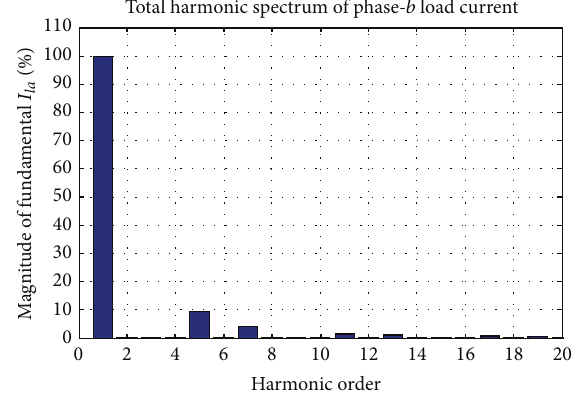
Figure 11: Frequency spectrum of phase- b load current.